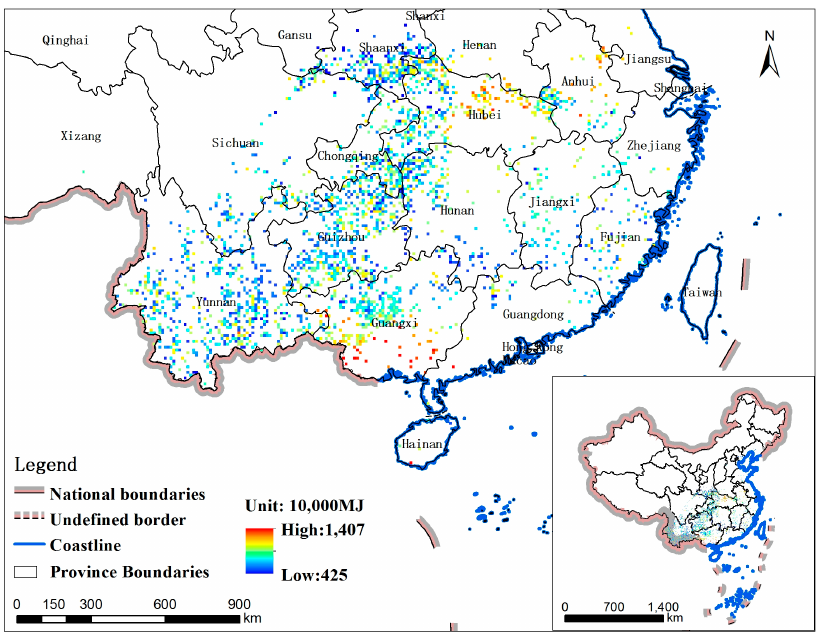
Figure 4. NEG of switchgrass-based bioethanol production.